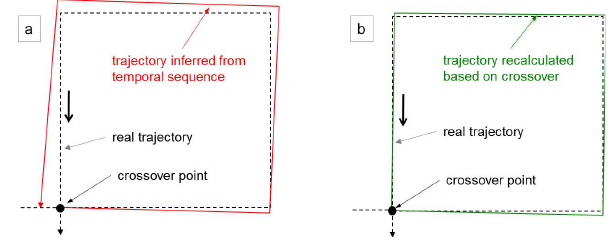
Fig. 6. Illustration of the contribution of crossover points in limiting registration errors. (a) Small positioning errors add up along the tra- jectory and grow unbounded. (b) By forcing the trajectory to cross itself at a given point, the position of each point within the loop can be recalculated backward; the registration error of each image is reduced.